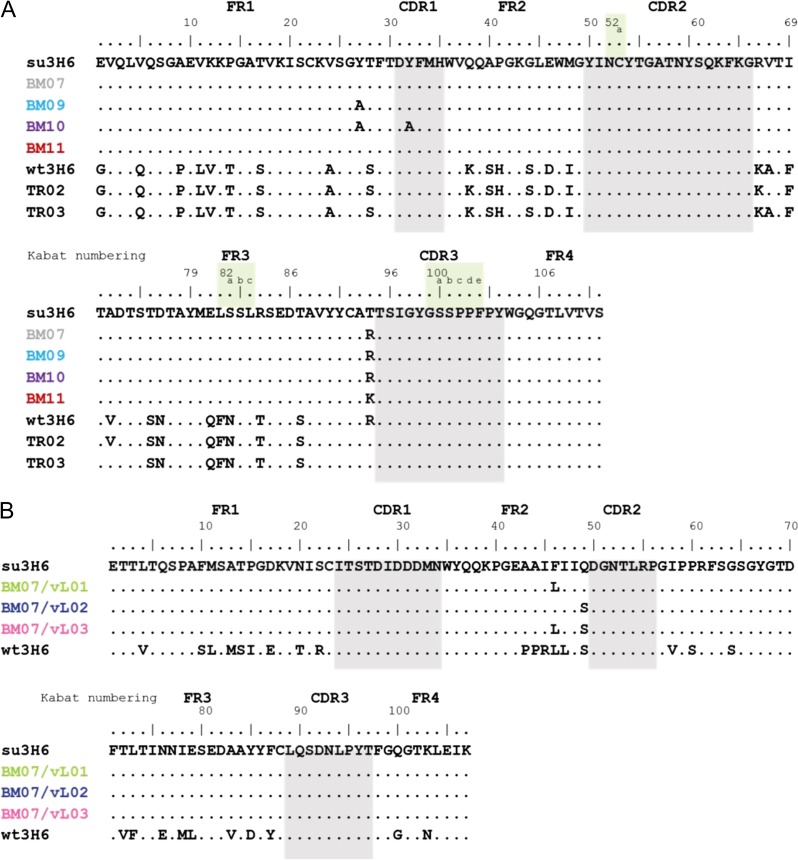
Amino acid sequence of (A) variable heavy chain and (B) variable light chain of su3H6, su3H6 variants (BM), wt3H6 variants (TR), BM07/vL variants and mouse antibody Ab2/3H6 (wt3H6). Kabat numbering scheme is used and the CDR regions are defined by Kabat using the abYsis tool (Kabat et al., 1991; Swindells et al., 2017). CDRs are highlighted in gray. Corresponding light chain for variants in panel A is su3H6, respectively, except for TR02/TR03 which have a wt3H6 light chain. BM07/vL variants in panel B use the BM07 heavy chain.